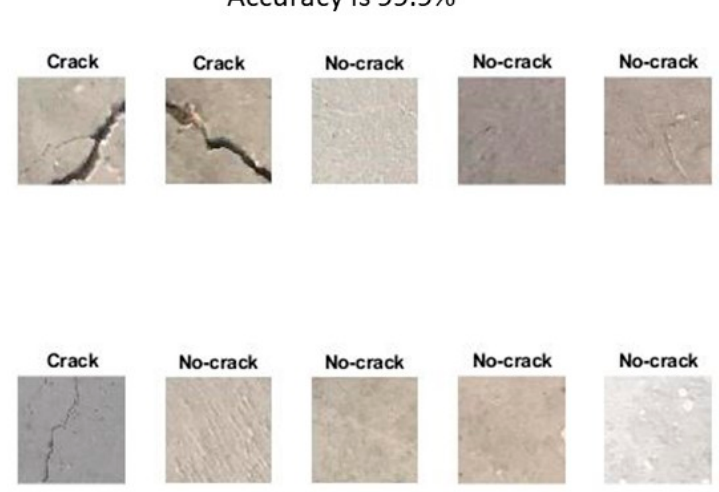
Figure 5. Classification and labelled images with the validation data.